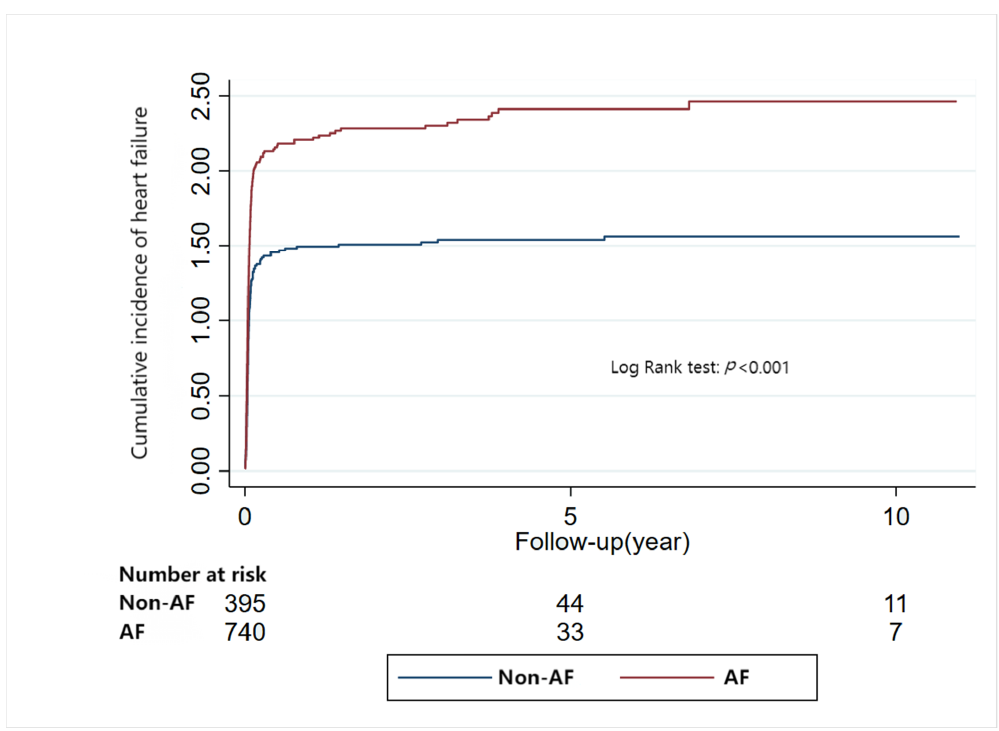
Figure 3. Relationship between atrial fibrillation and heart failure in restrictive cardiomyopathy (Kaplan-Meier Analyses).